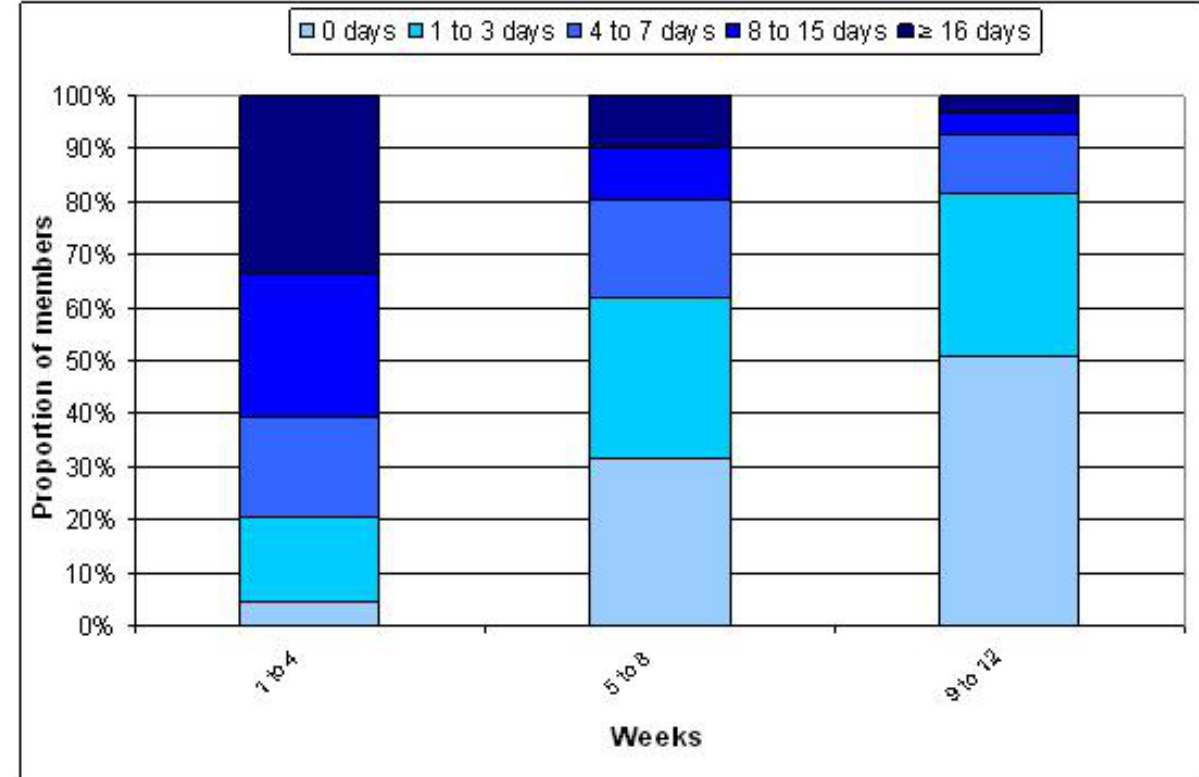
Figure 2. Website use from enrollment to 12 weeks among 12 week